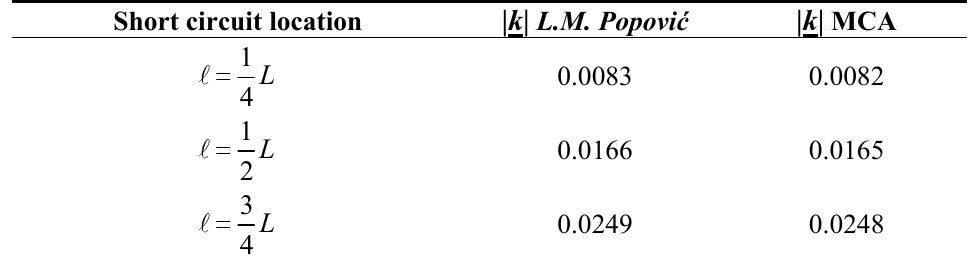
Table 2. Comparison between multiconductor cell analysis (MCA) and k -factor for short circuit along the line A.